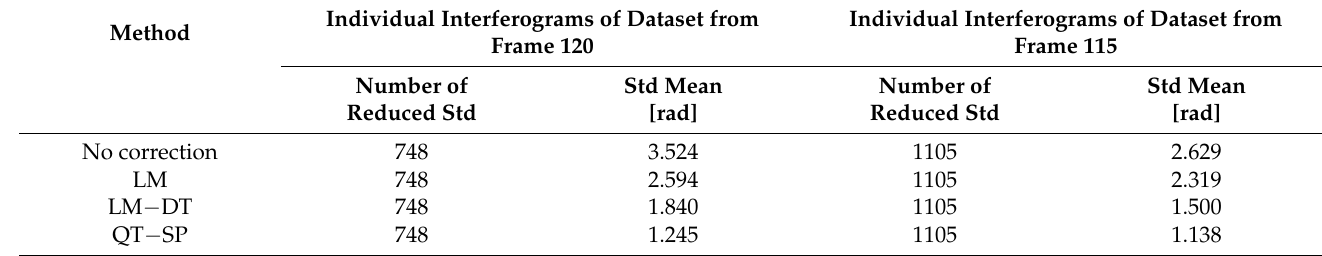
Table A1. Statistical evaluation on tropospheric delay corrections of Sentinel − 1A datasets from frame 120 and frame 115.